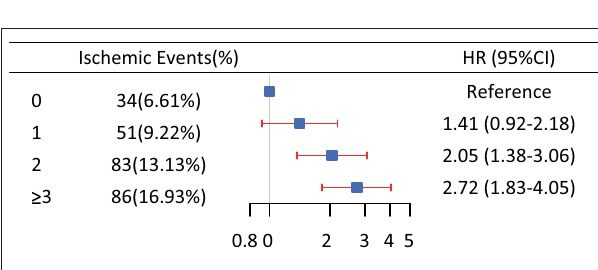
FIGURE 2 | Incidence of ischemic events among cumulative risk-score categories.